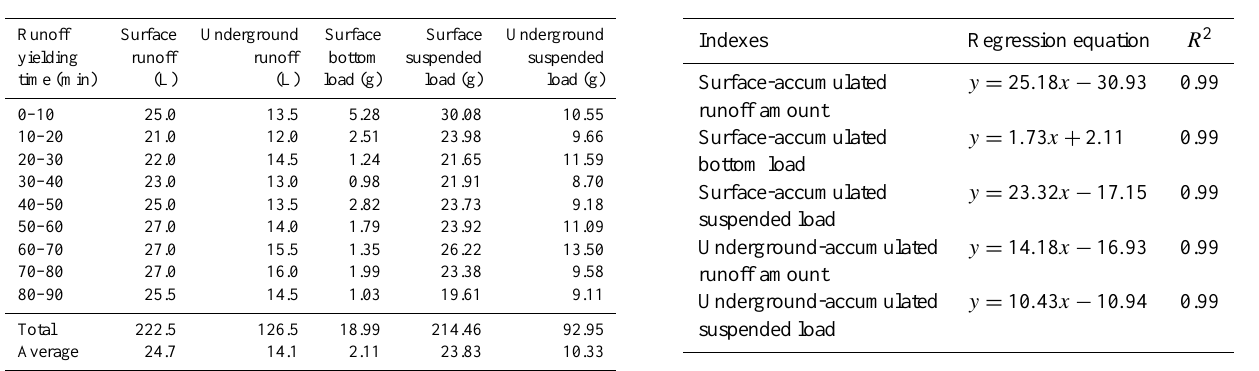
Table 6. Relationship between the accumulation of runoff and sed- iment production and rainfall duration.